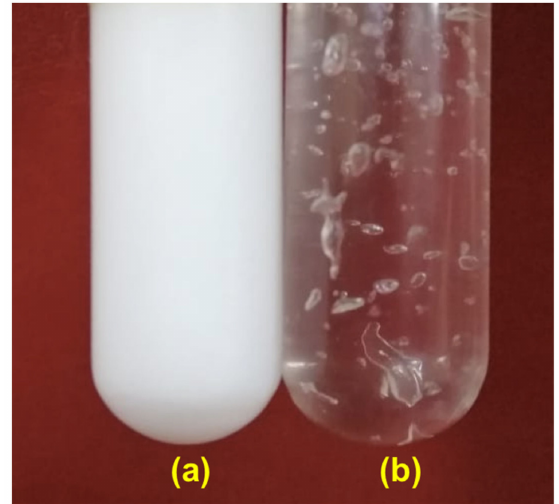
Figure 2. ZnO NPs synthesized by the chemical precipitation method under the effect of the ultra- sound wave irradiation, where ( a ) is in the aqueous solution, and ( b ) is stabilized by Carbopol